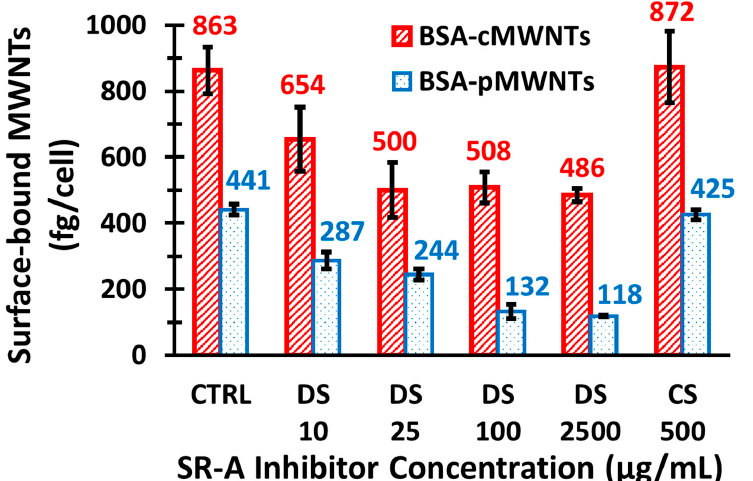
Figure 5. Effect of dextran sulfate on BSA-MWNT binding to RAW 264.7 cells at 4 ◦ C. MWNTs suspended in a 0.10 mg/mL BSA working solution were mixed with an equal volume of 2X-concentrated, serum- and sodium bicarbonate-free medium to give a MWNT concentration of 100 µ g/mL followed by the addition of chondroitin sulfate (CS) or the SR-A1 antagonist dextran sulfate (DS) at various concentrations as described in the Methods. The serum- and sodium bicarbonate-free medium control contained the same 100 µ g/mL BSA-MWNTs, but without CS or DS. After initial plating and attachment to the substrate, cells were pre-incubated with serum-free medium (in the absence of MWNTs) for 2 h at 37 ◦ C to deplete the serum in the cells. The cells were then pre-chilled to 4 ◦ C and incubated at 4 ◦ C for 1 h in serum- and sodium bicarbonate-free test medium that contained either a 0.10 mg/mL BSA working solution without MWNTs, with BSA-pMWNTs ± DS or CS (blue bars and line), or with BSA-cMWNTs ± DS or CS (red bars and line). Surface-bound MWNTs were extracted and quantified using the SDS-PAGE method. The numbers above the bars are the mean femtograms of MWNTs/cell. Data are the mean of ≥ 3 independent experiments ± SD.